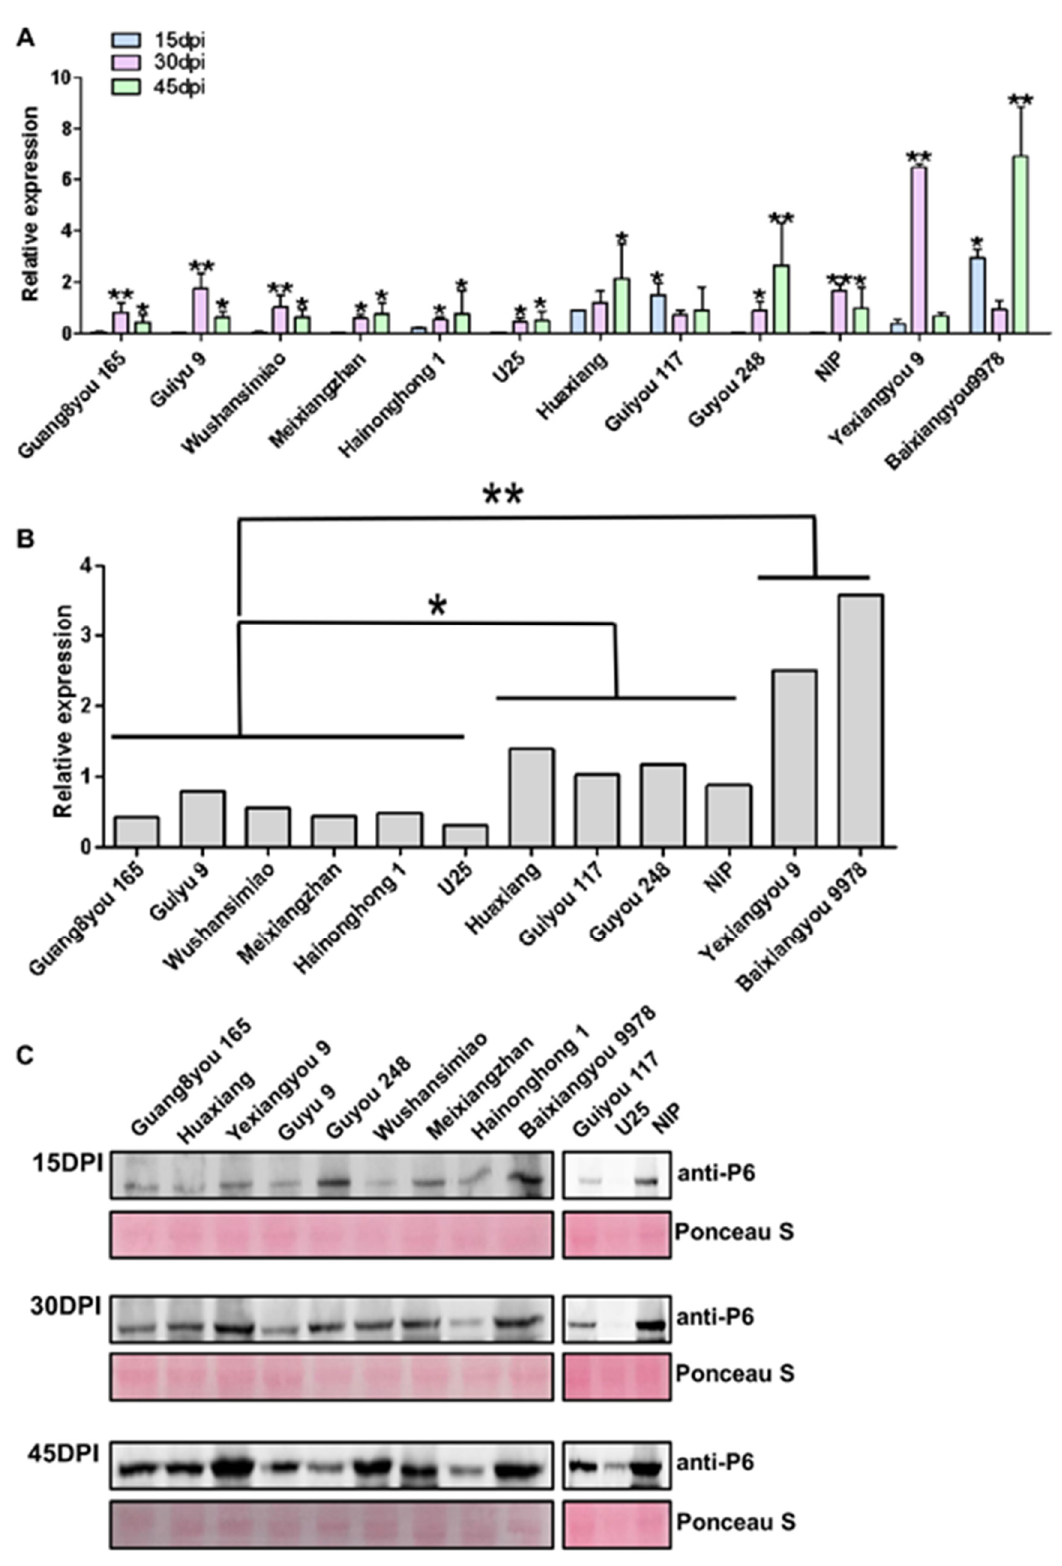
Figure 4. The virus accumulation in the plants infected with SRBSDV at 15, 30, and 45 dpi: ( A ) RT-qPCR analysis for the transcription level of SRBSDV-S10; ( B ) the mean virus titers of three disease stages in infected plants; ( C ) Western blot detection for the accumulation level of SRBSDV-P6. “ * ” indicates a significant difference ( p < 0.05), “ ** ” indicates an extremely significant difference ( p < 0.01).